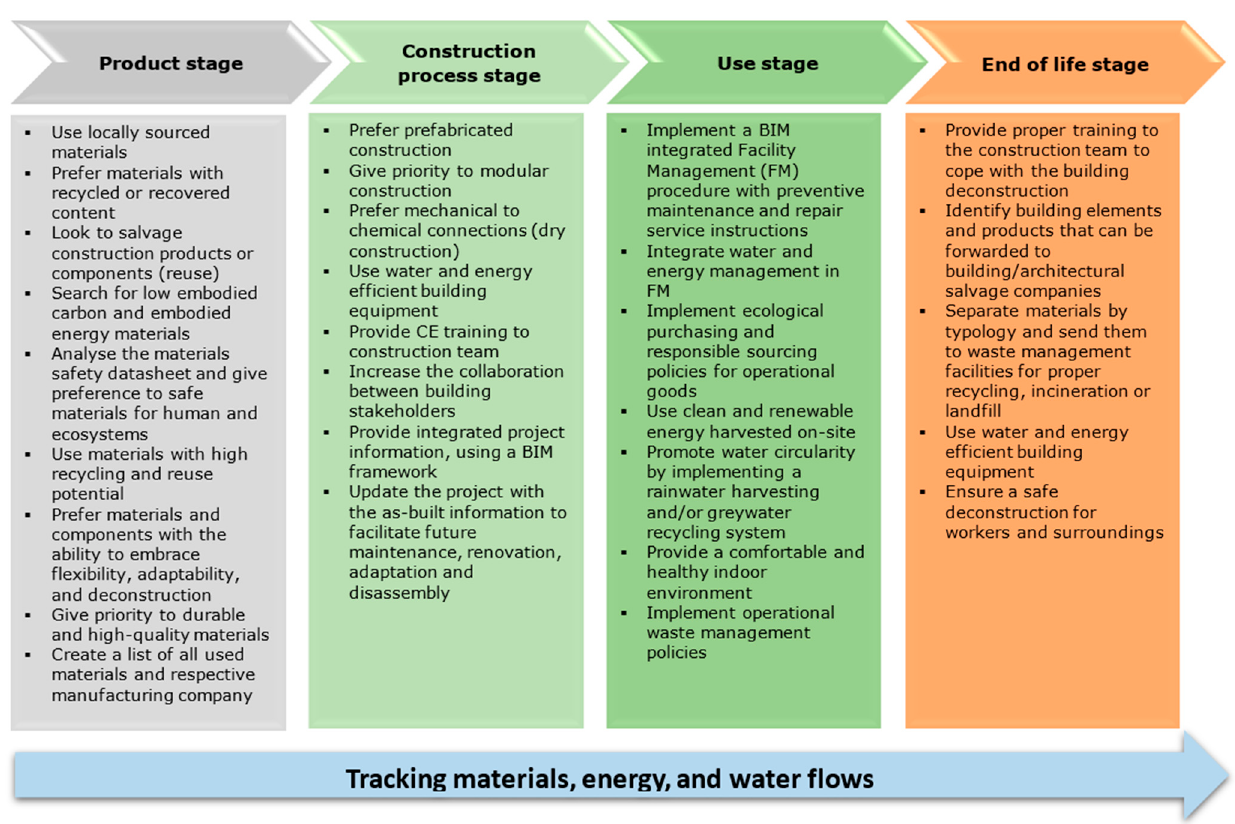
Figure 3. A framework for CE implementation throughout the building’s life